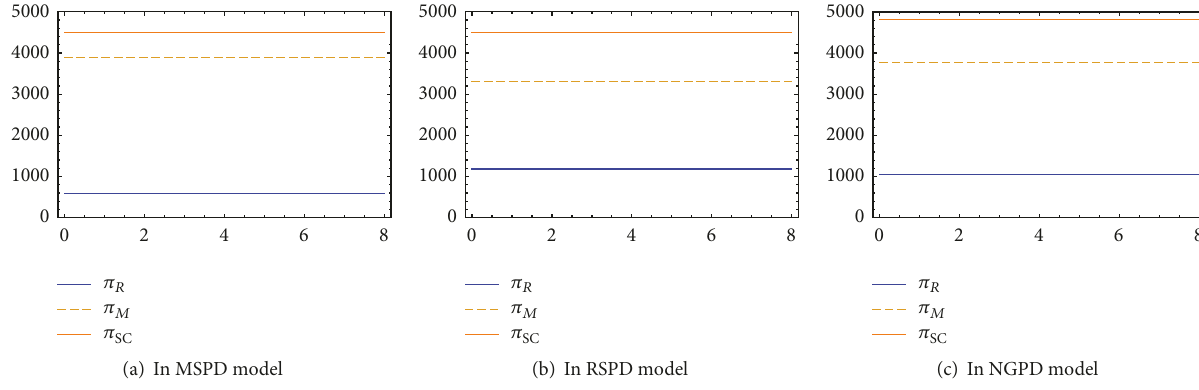
Figure 3: The change of expected profits with the parameters 𝑞 .